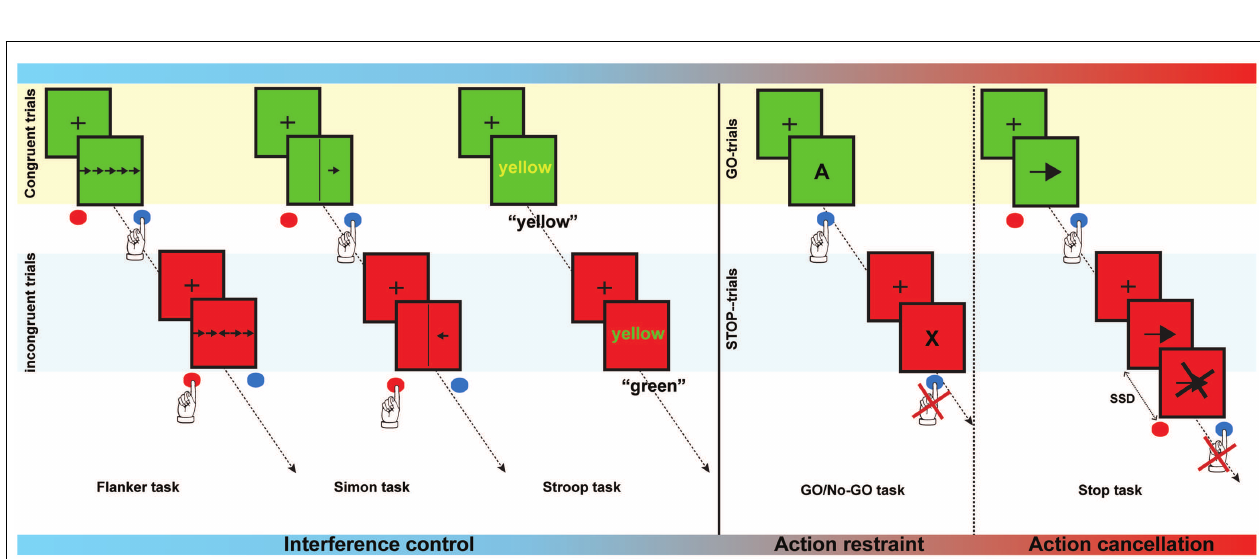
or a different color (incongruent). Subjects are instructed to name to color of the word but not the word itself. In the Go/No-go task , subjects need to respond as fast as possible when letters are presented (Go-trials), but must withhold the response when a certain letter (e.g., “X”) is presented (Stop-trials). In a Stop-signal task , the participant is asked to respond as fast as possible by pressing a button to a stimulus (Go-trials) that is presented. On a minority of trials, a stop-signal is presented and the subject is asked to suppress the response when the stop-signal occurs. Task demands gradually increase from interference control to action